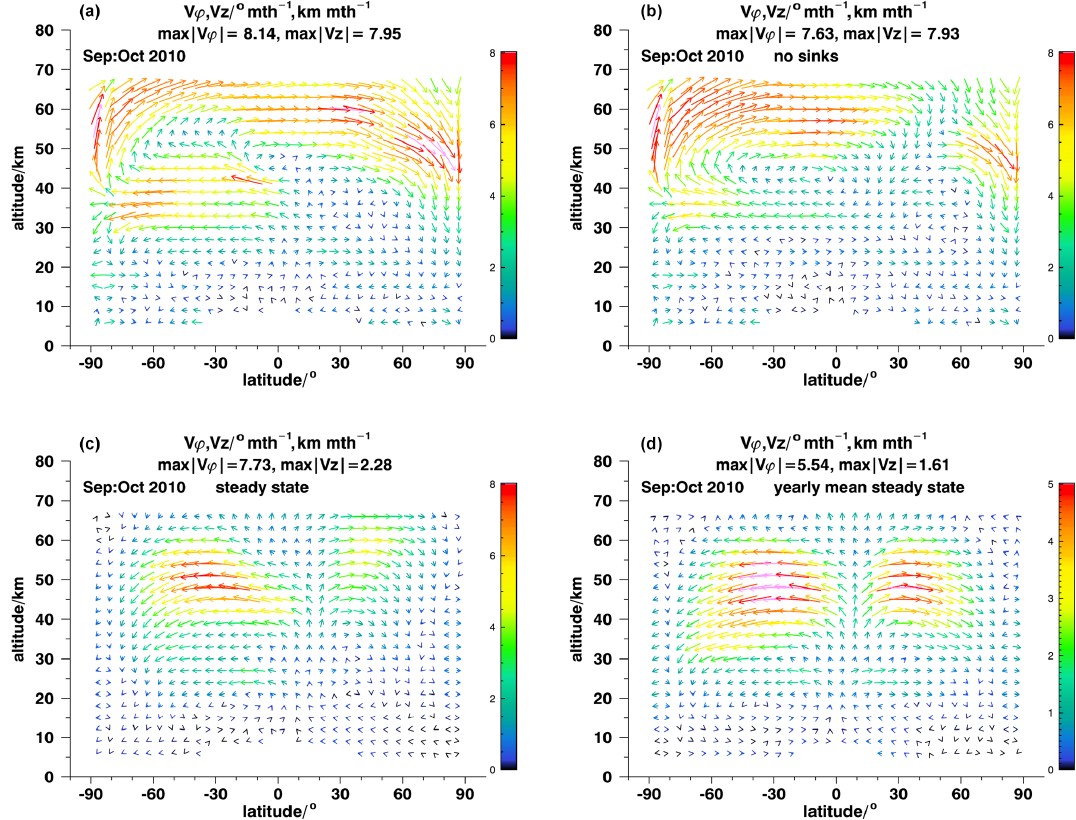
Figure 2. The meridional middle atmospheric circulation as retrieved with ANCISTRUS for September–October 2010 under realistic as- sumptions (a) , without consideration of sinks of trace gases (b) , and for sinks perfectly balanced by transport for actual (c) and annual mean (d) conditions. For details, see Fig.